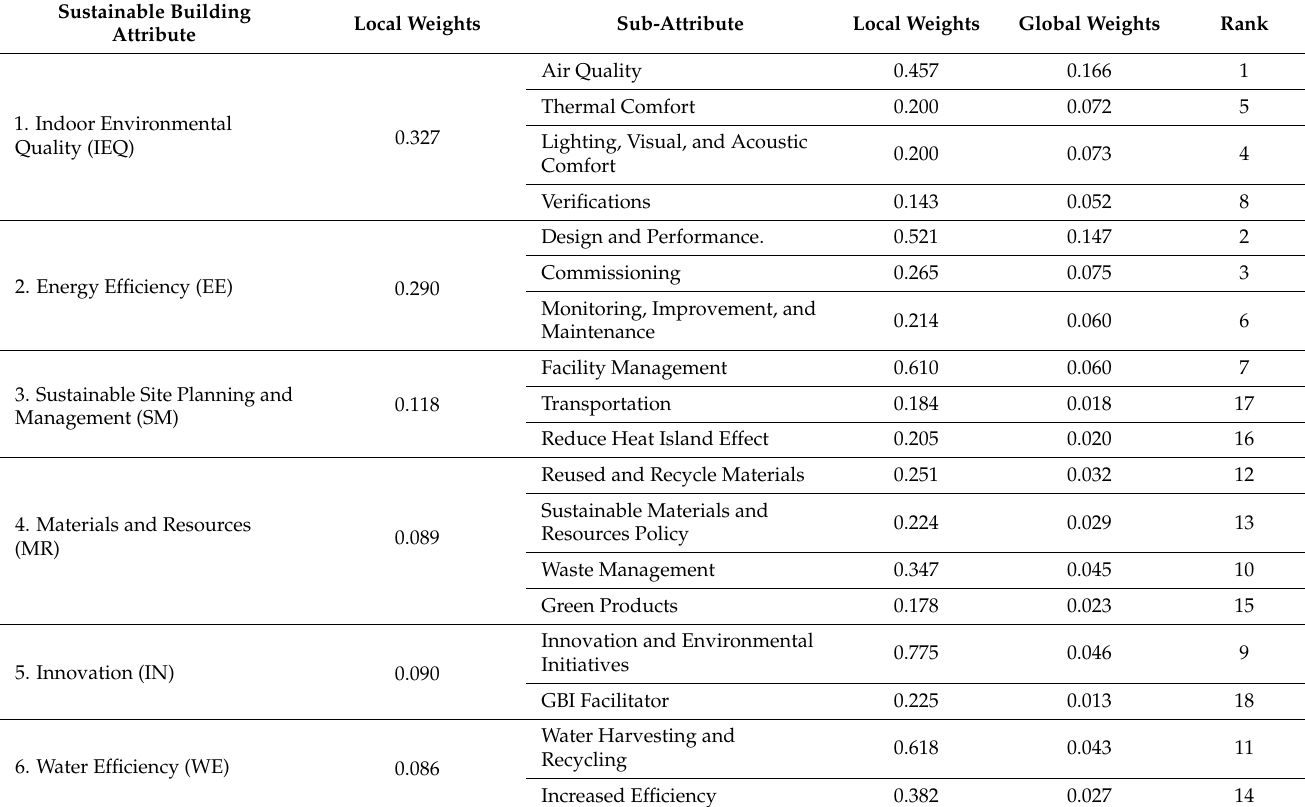
Table 10. Composite priority weights for ‘attribute–sub-attribute’ parameters of PBO green building attributes influencing rental depreciation and obsolescence for the conventional office